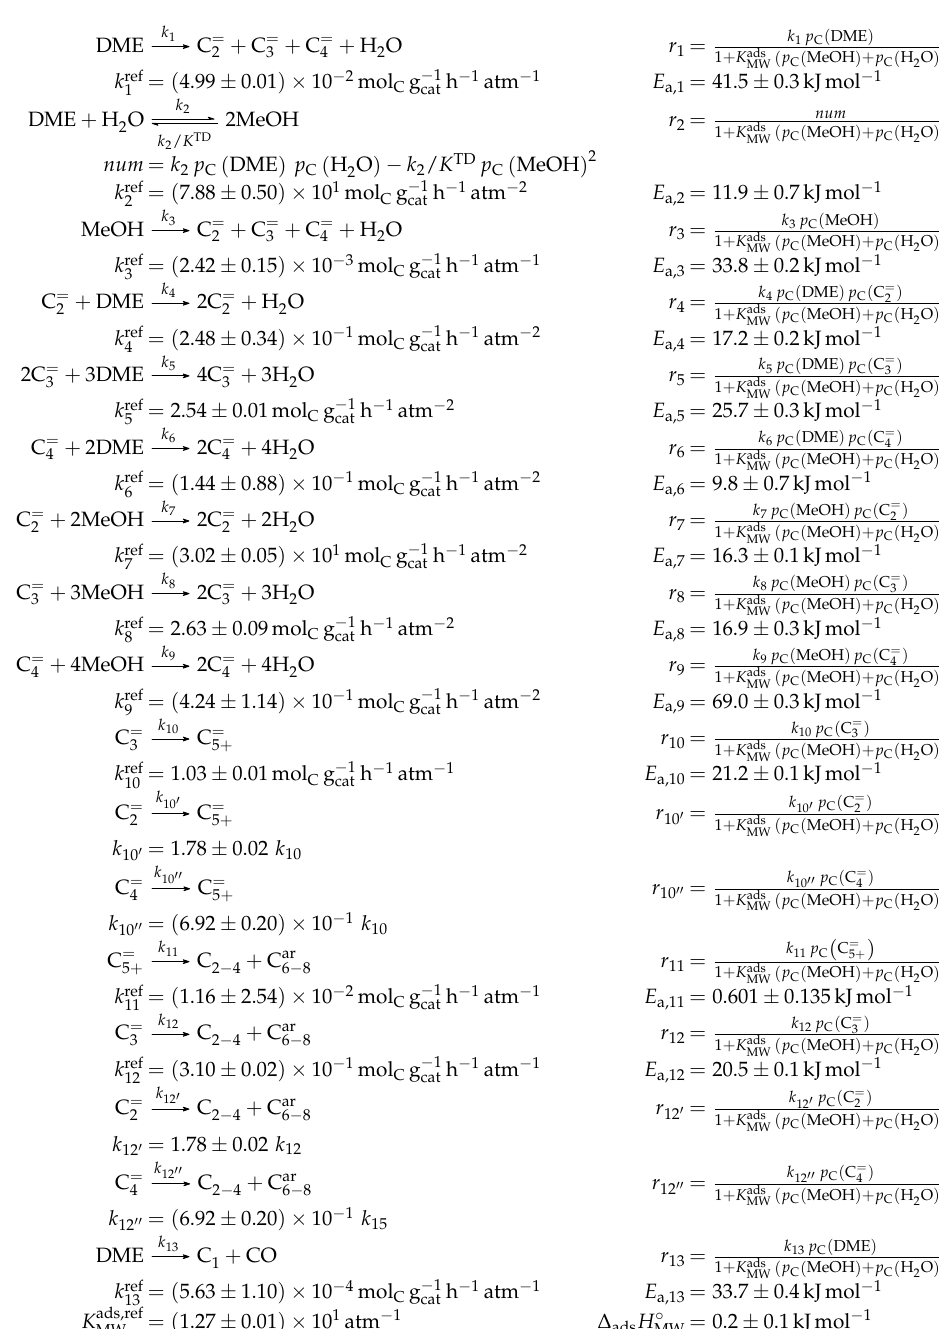
Scheme 25. Reaction network, rate equations and estimated parameters for the model by Pérez-Uriarte et al. [253]; K TD is calculated with an own correlation [109] (see Section 2.1); some values are from [276]. The net rates of production are presented in Scheme